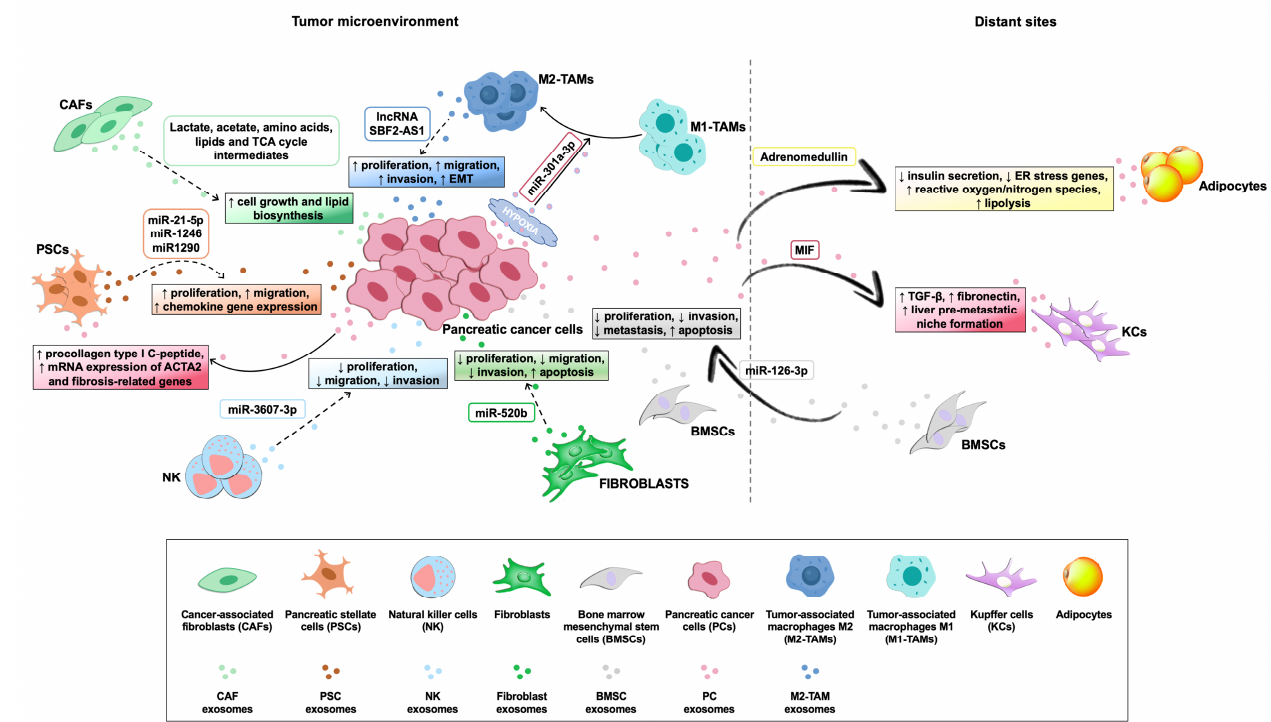
Figure 3. Roles of exosomes in the cross-talk among pancreatic cancer cells and cells within the tumor microenvironment, or at distant sites. Exosomes derived from pancreatic cancer (PC) cells and microenvironment cell components, together with their specific cargo molecules (rounded boxed text), play different roles (squared boxed text) in intercellular communication, by modulating metabolic activity and/or biological features of cells within the tumor microenvironment, or at distant sites. Solid arrows indicate the effects of PC cell-derived exosomes on recipient cells, whereas dashed arrows indicate the effects of microenvironment cell component-derived exosomes on PC